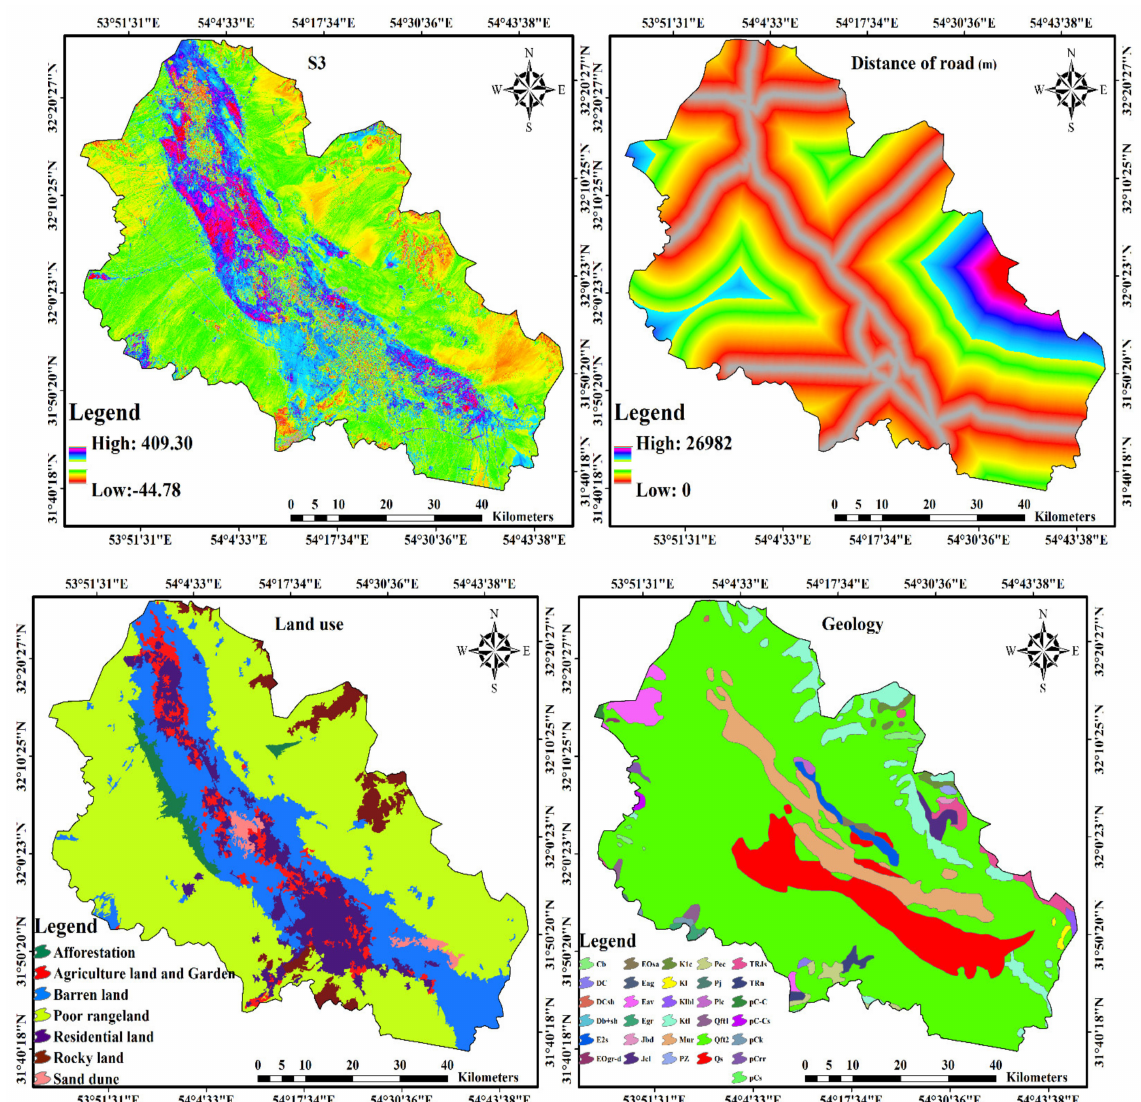
Figure 3. Examples of covariates for the study area (for geological codes refer to Table